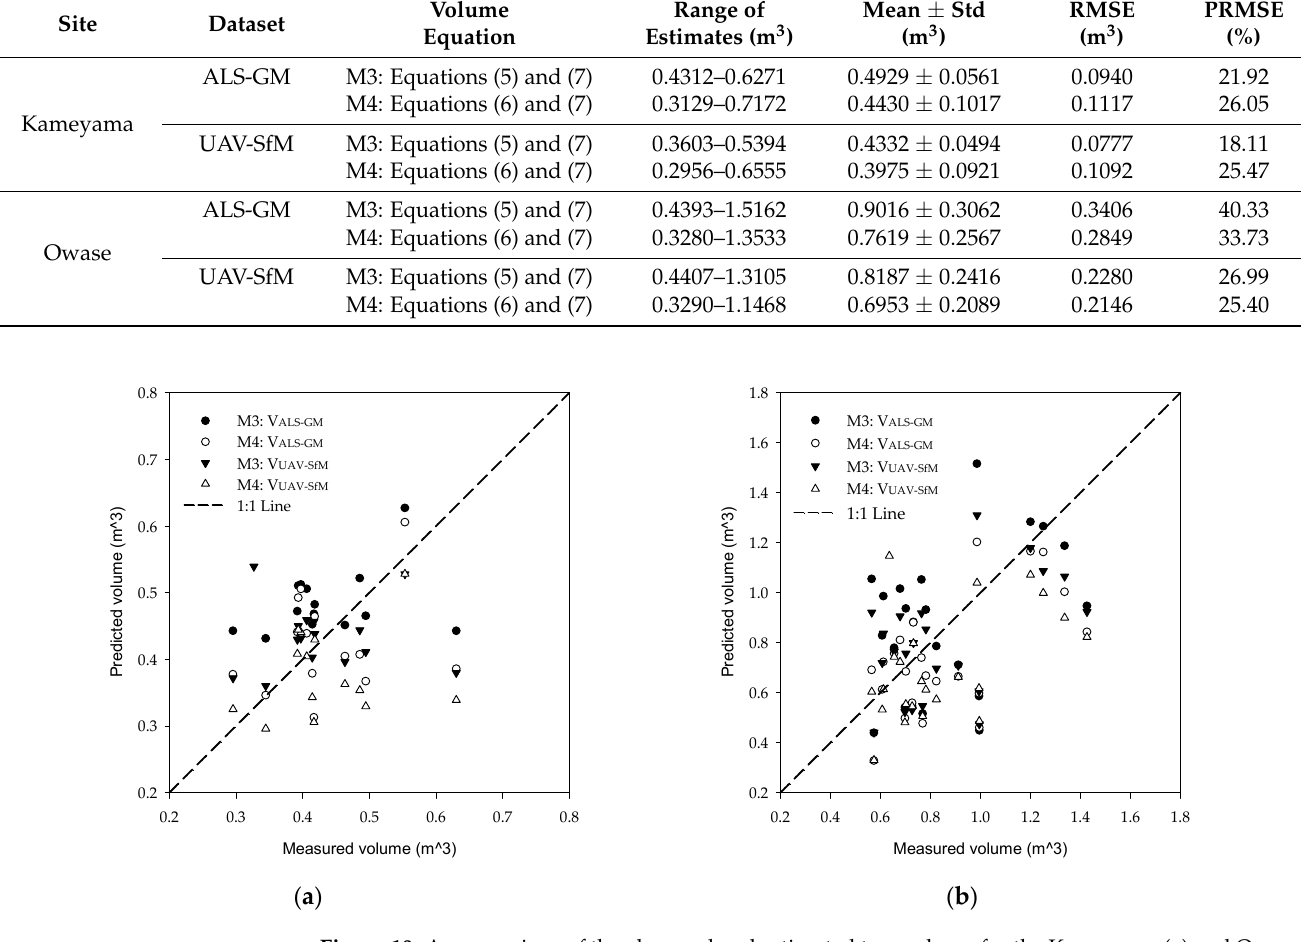
Figure 10. A comparison of the observed and estimated tree volume for the Kameyama ( a ) and Owase forests ( b ). In ( a , b ), the dot and circle represent the estimation of Model-3 (Equations (5) and (7)) and Model-4 (Equations (6) and (7)) through the ALS-GM datasets, and the black triangle and white triangle stands for the estimation of Model-3 and Model-4 through the UAV-SfM datasets. Please see Table 7 for the details of accuracy measures. Table 7. Summary of the tree volume estimation and accuracy evaluation for the Kameyama and Owase forests.